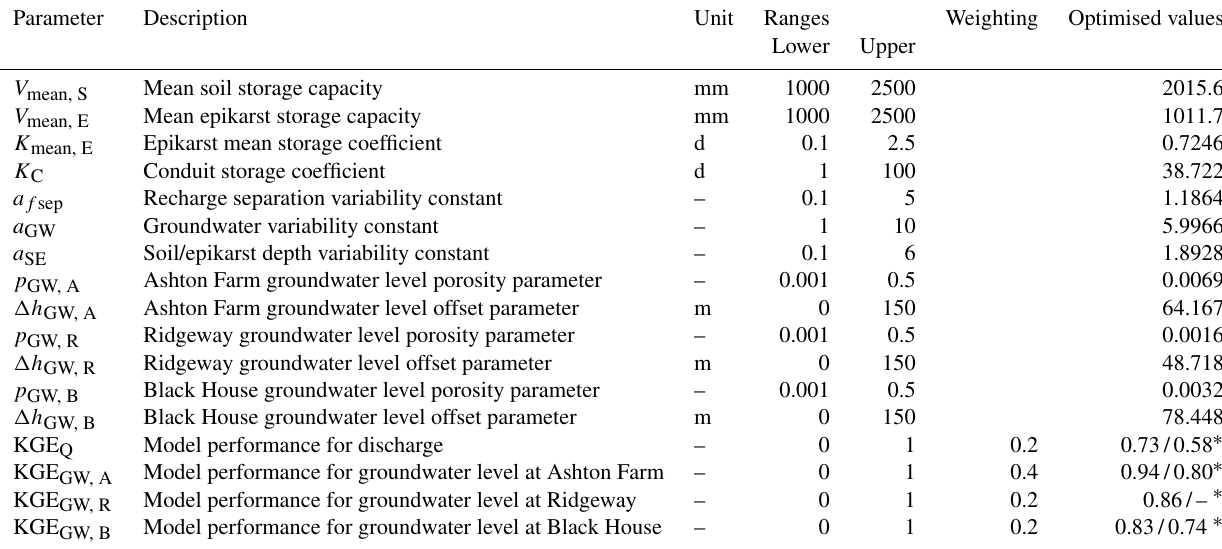
Table 2. Model parameters, descriptions, ranges and optimised